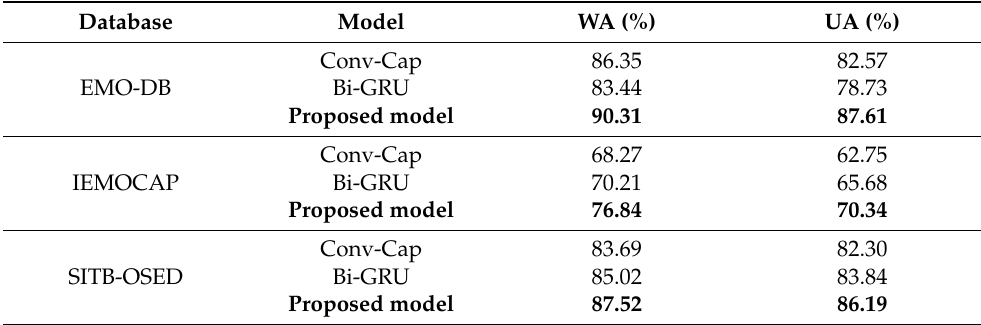
Table 4. A comparison of the performance of different architectures of the proposed model in terms of weighted accuracy (WA) and unweighted accuracy (UA) using different datasets.